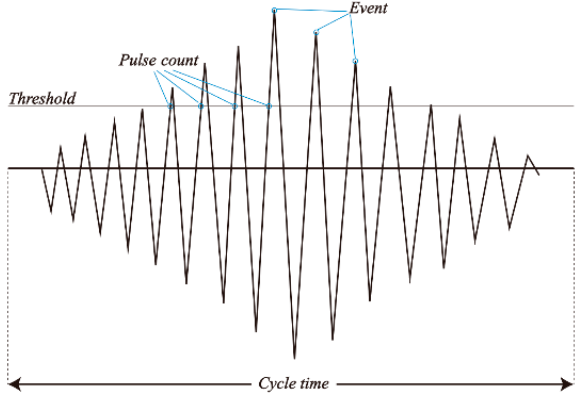
Figure 1. Illustration of ‘pulse count’ and ‘event’ of MBN signals.